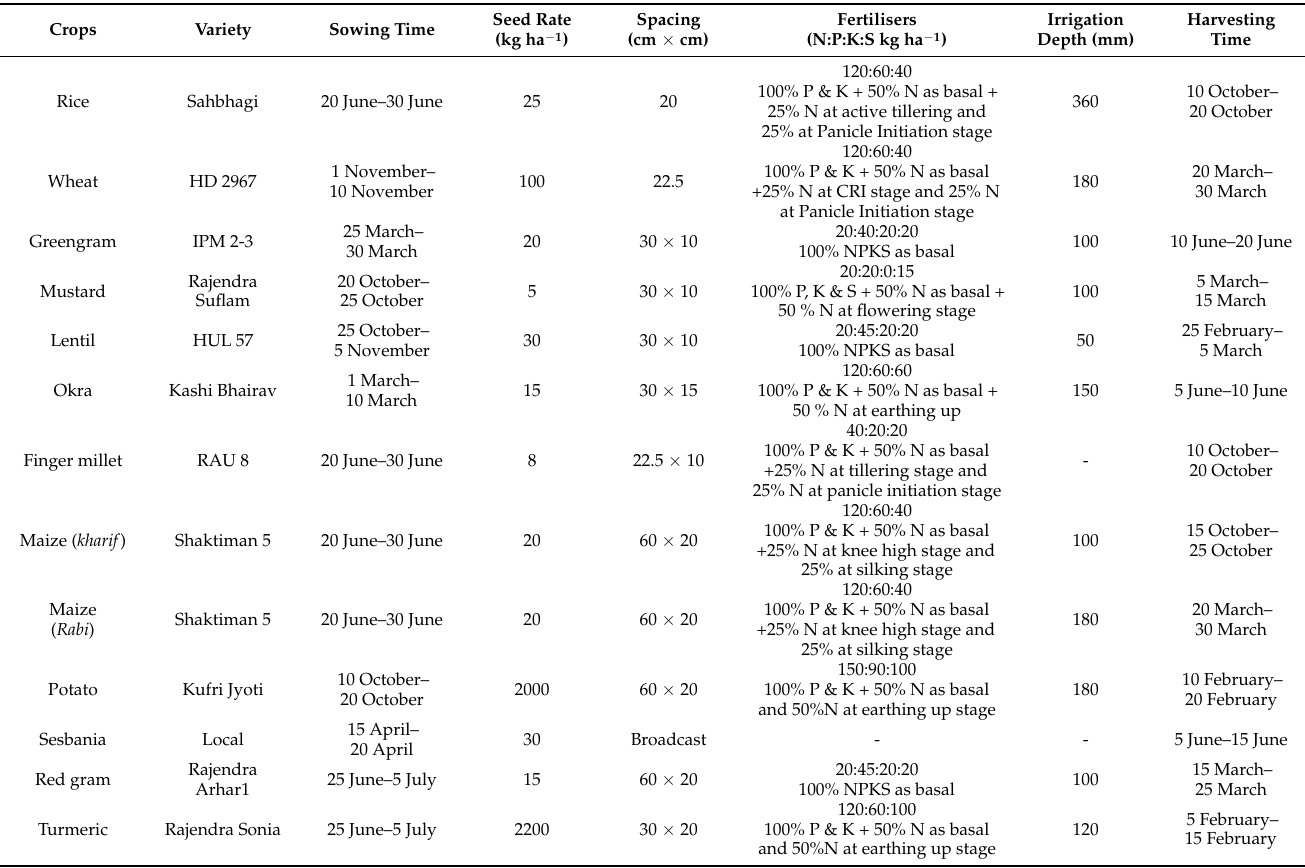
Table 2. Details of agronomic practices for different crops in the cropping